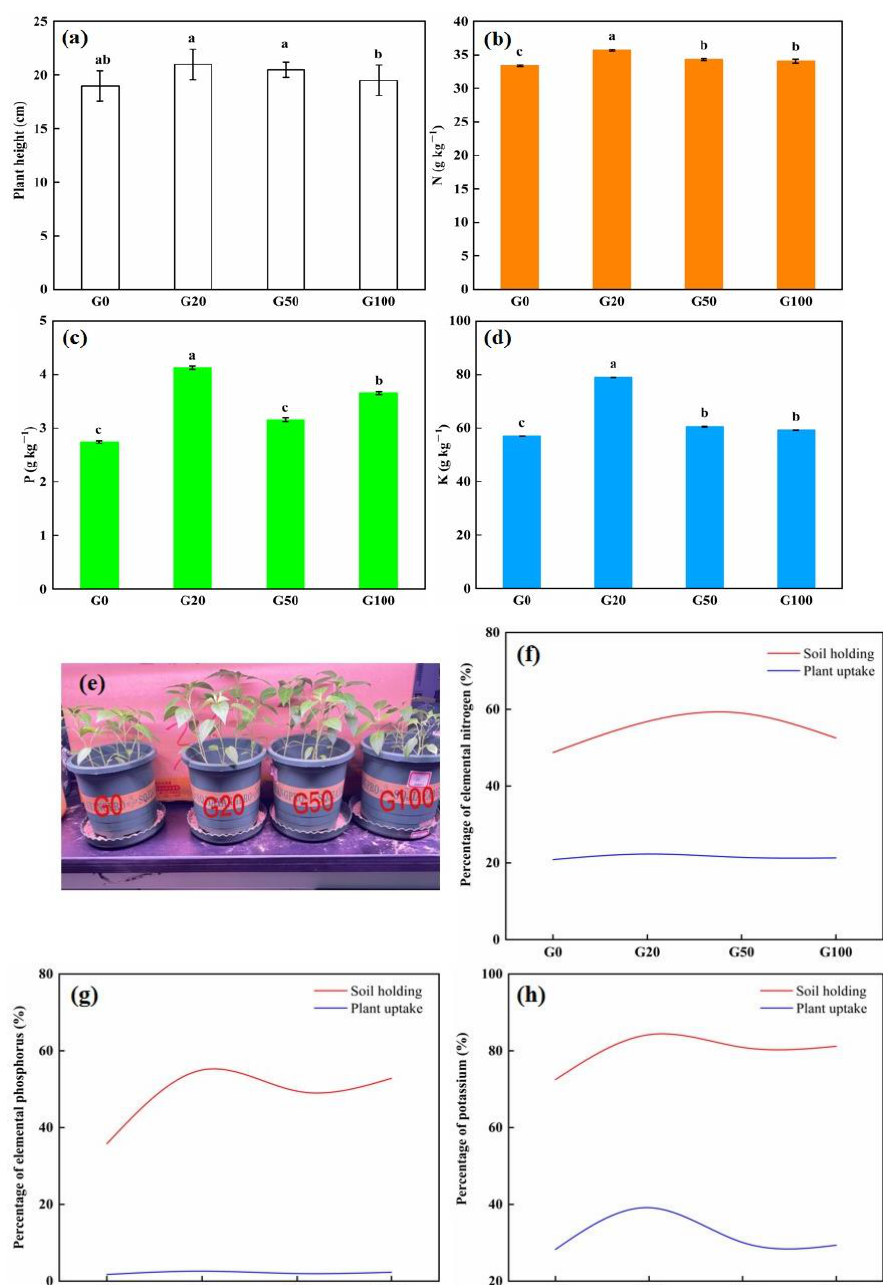
Figure 4. Effect of different concentrations of graphene added to the soil on the growth and nutrient uptake of pepper plants grown from seed for 60 days. ( a ) Plant height; ( b ) total nitrogen; ( c ) total phosphorus; ( d ) total potassium; ( e ) pepper plants after 60 days; ( f ) nitrogen biplot; ( g ) phosphorus biplot; ( h ) potassium biplot. Error bars represent the standard error of the mean ( n = 5). The letters a, b, and c indicate a statistically significant difference at p < 0.05 within each group comparison between the treatment.